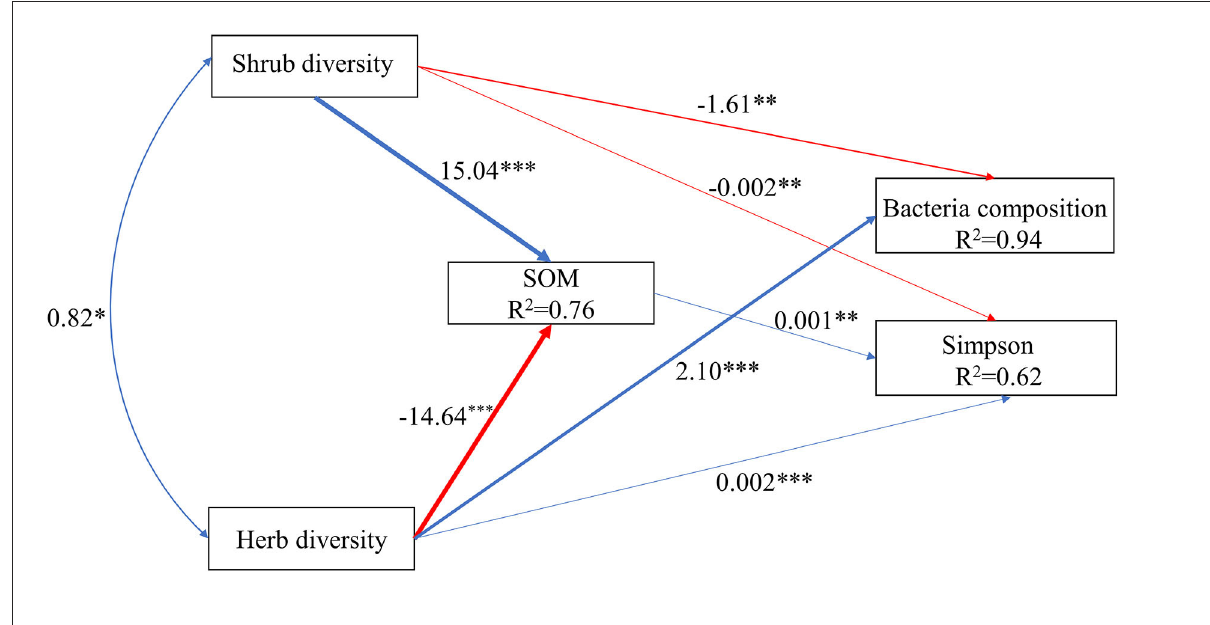
FIGURE7 Structural equation model (SEM) of bacterial diversity and composition in relation to environmental factors. Solid arrows indicate significant effects ( P < 0.05). Arrow width corresponds directly to the standardized path coefficient. The blue arrow represents the positive impact, and the red arrow represents the negative impact. R 2 values associated with response variables indicate the proportion of explained variation by relationships with other variables. Values associated with arrows represent standardized path coefficients. Herb diversity: four plant diversity indices of the herb layer; SOM: soil organic matter; shrub diversity: four plant diversity indices of the shrub layer; bacterial composition: the sequencing data for bacteria at the phyla level; Simpson: Simpson index of bacteria community. *** P < 0.001; ** P < 0.01; * P <